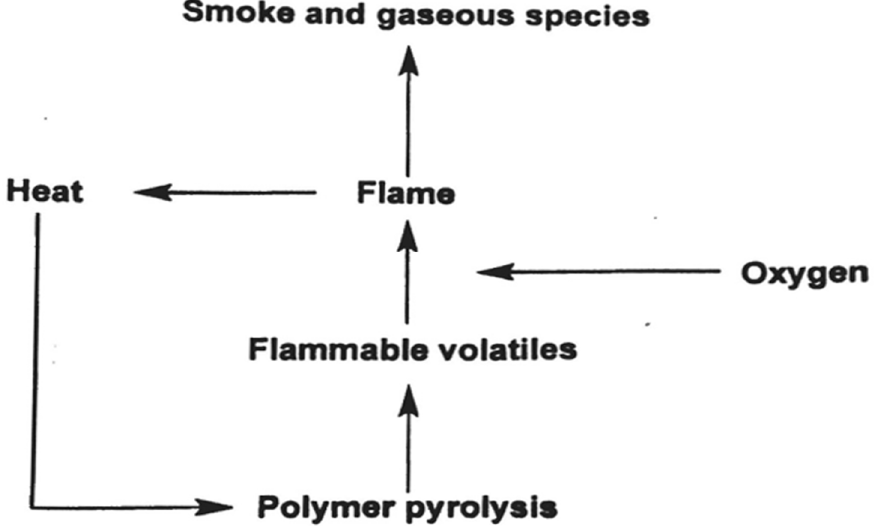
Figure 1. Polymer Combustion Process.